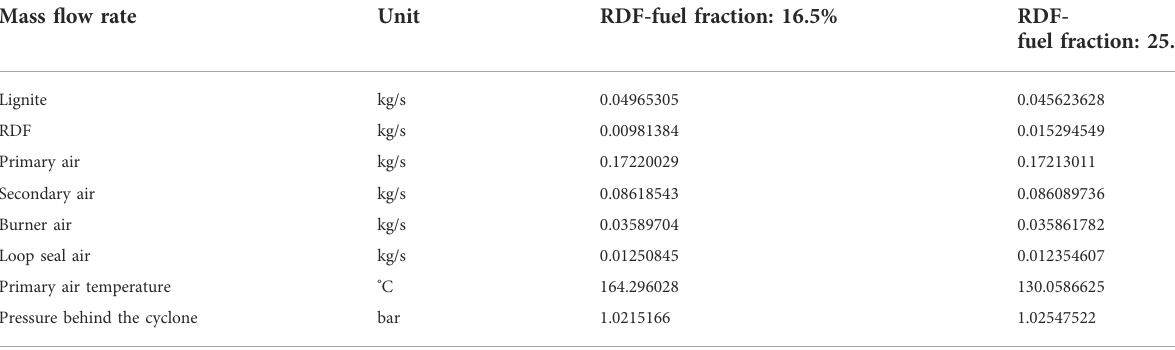
TABLE 7 Boundary conditions of the steady-state simulation with 16.5% and 25.1% RDF.